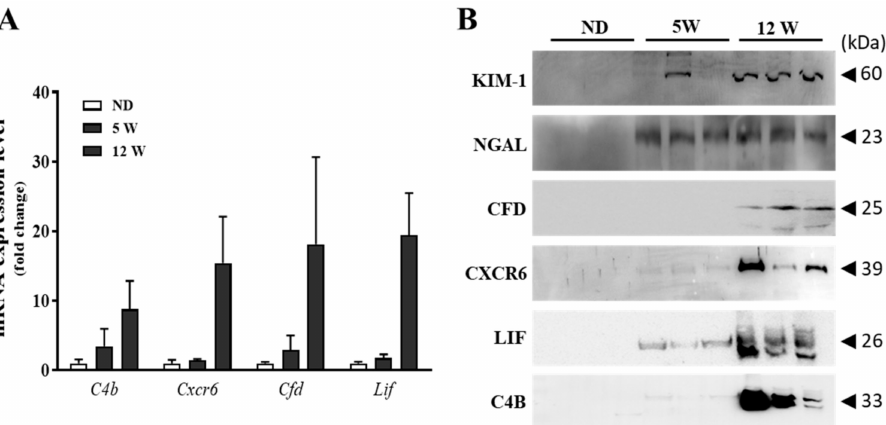
Figure 5. Expression levels of candidate biomarkers in DN rat model. ( A ) mRNA expression levels were determined using qRT-PCR. ( B ) Collected urines were subjected to Western blotting for detecting KIM-1, NGAL, CFD, CXCR6, LIF, and C4B